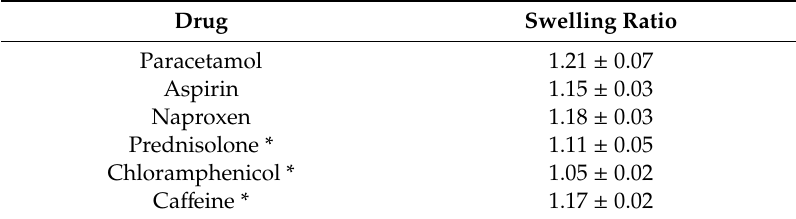
Table 3. Swelling ratios of the individual 3D-printed layers after 24 h in water. * Indicates